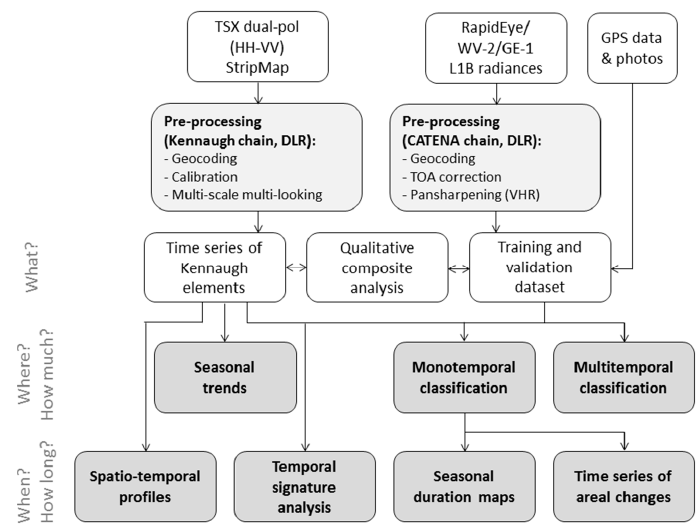
Figure 3. Processing workflow.